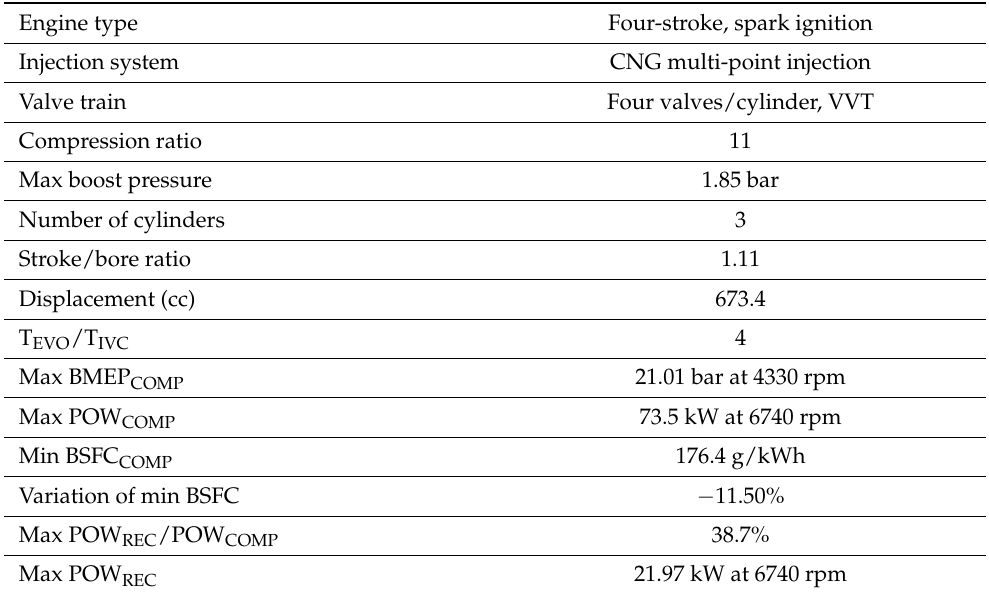
Table 3. Main characteristic of the realistic separated electric compound engine.